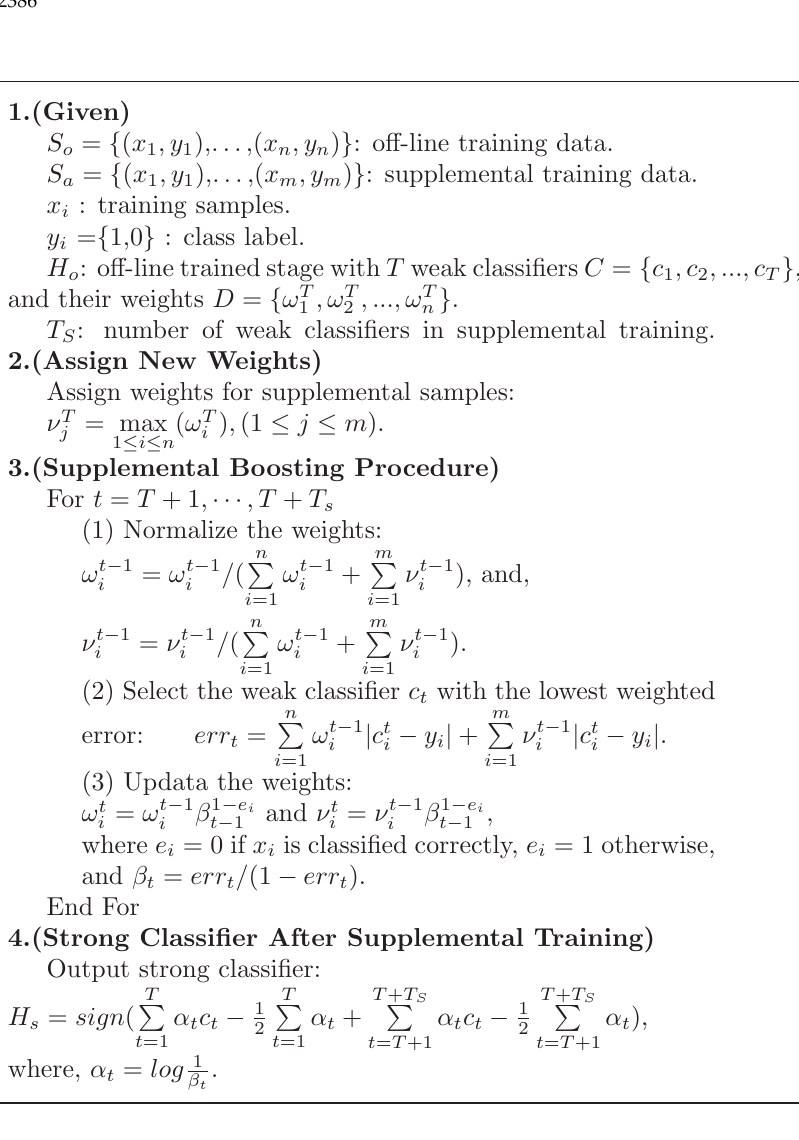
Figure 5. The program pseudo code of the supplemental training